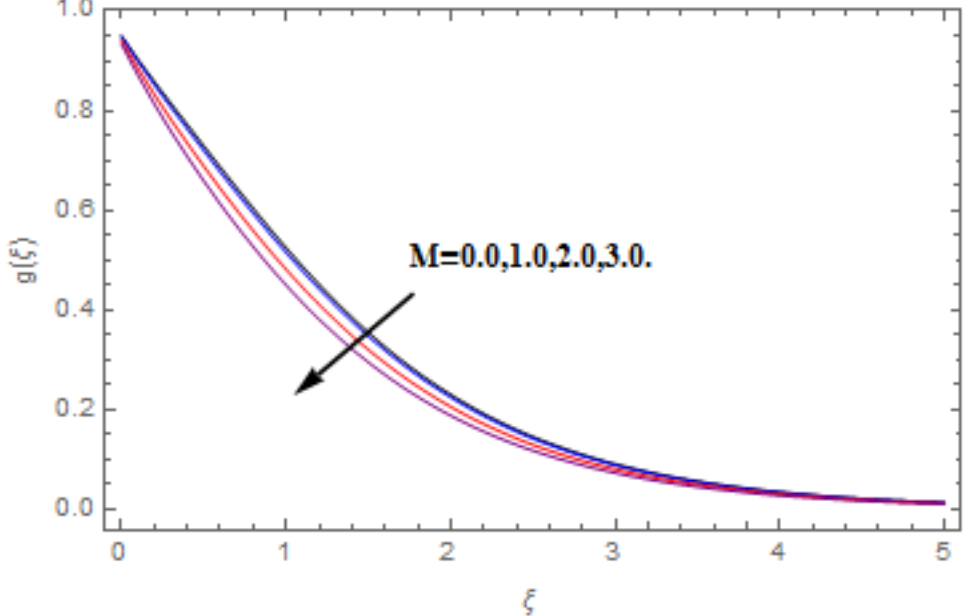
Figure 5. Varation in g ( ξ ) against M , when ψ = 0.2, Nt = Nb = 0.5, Le = 1.0, Ec = 1.0, Pr = 1.2, Figure 5. γ = 0.1, κ = 1.0. Molecules 2020 , 25 , x FOR PEER REVIEW